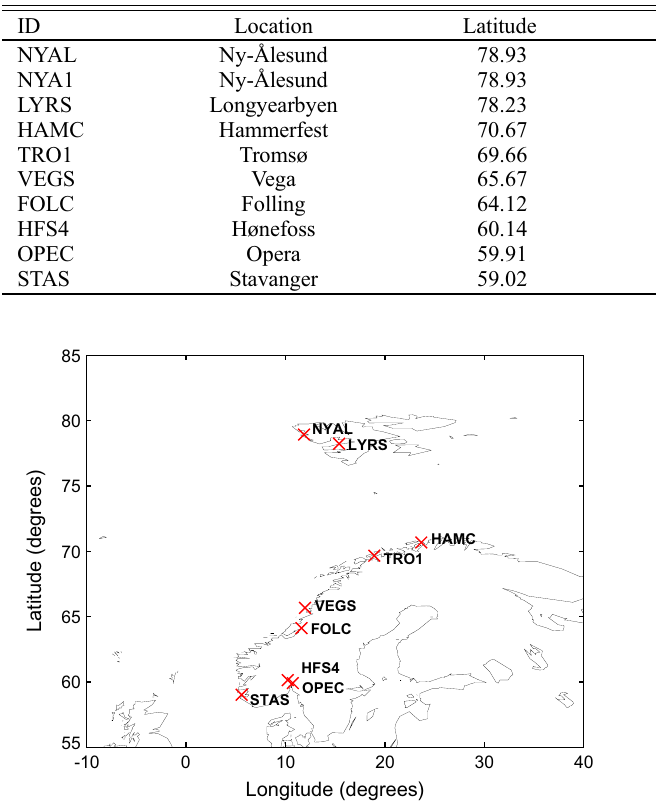
Fig. 1. Geographic locations of the GNSS receivers used in this study.